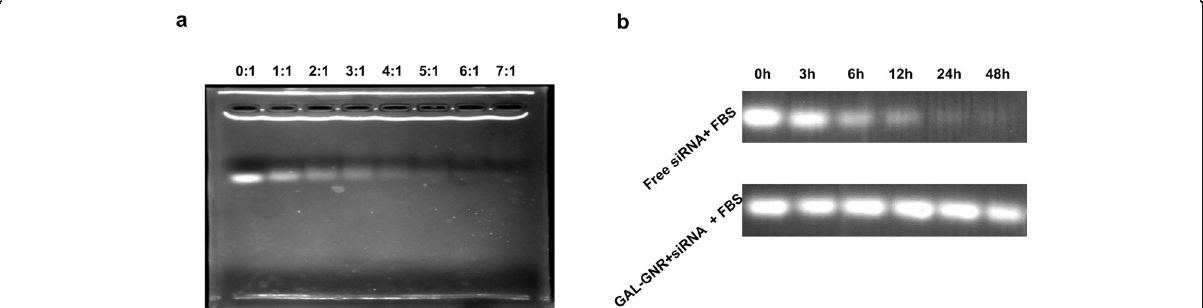
Fig. 2 Gel shift assays. a siRNA-loading capacity of GAL-GNR. One microgram of siRNA was mixed in equal volumes with different mass ratios of GAL- GNR. After incubation for 30min, a gel migration assay was used to assess the siRNA loading capacity of GAL-GNR. b Stability of siRNA in mouse serum. One microgram of BARF siRNA was inoculated with the GAL-GNR at the mass ratio of 1:6 and was subsequently added to fresh murine serum. After reaction of 0, 3, 6, 12, 24, and 48h at 37 °C, siRNA from GAL-GNR-siBARF was extracted by 2% SDS and were visualized with Ethidium Bromide